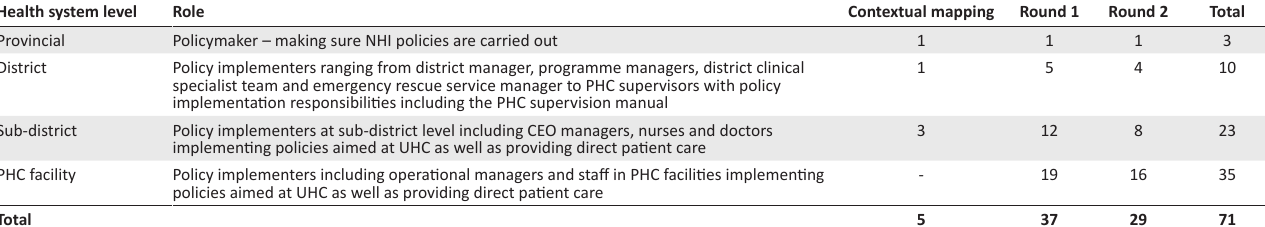
TABLE 1: Overview of key informants, research phase, role and where they worked (health system level). Health system